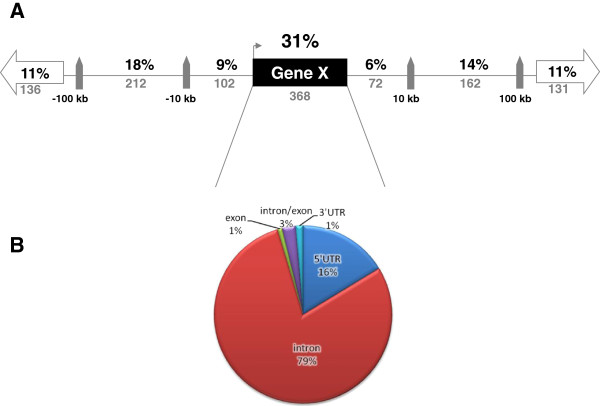
Genomic distribution of GBS relative to nearby genes.A The percentage of GBS that are present intragenically or within a certain range from the nearest gene are indicated, showing that the number of GBS located within a gene is highest. B Intragenic GBS can be further subdivided into subregions: 5’UTR (exon or intron), intron, exon, intron/exon overlap and 3’UTR regions.